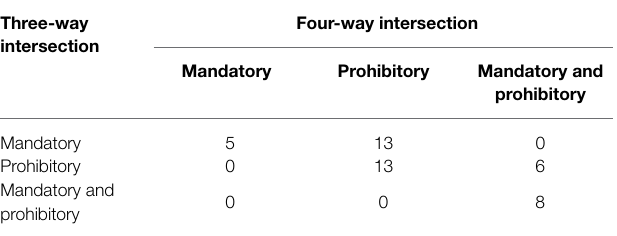
TABLE 2 | Cross-tabulation table of traffic signs changed from three-way intersections to four-way intersections. Three-way